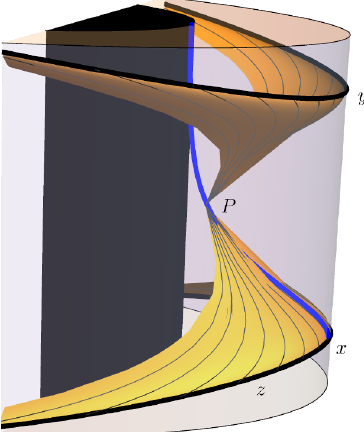
Figure 11 . Geometry of the holographic radar: a pulse sent from a point z reflects off an object (following the thick blue geodesic) at a point P and is later recorded at y . This is shown here in the geometry surrounding a BTZ black hole (the inner cylinder), while all measurements are done within the finite-temperature system at the outer boundary of the cylinder. The yellow surface displays null geodesics from P that reach the boundary. Any points z and y at the intersection of this surface and the boundary would probe the same bulk point P